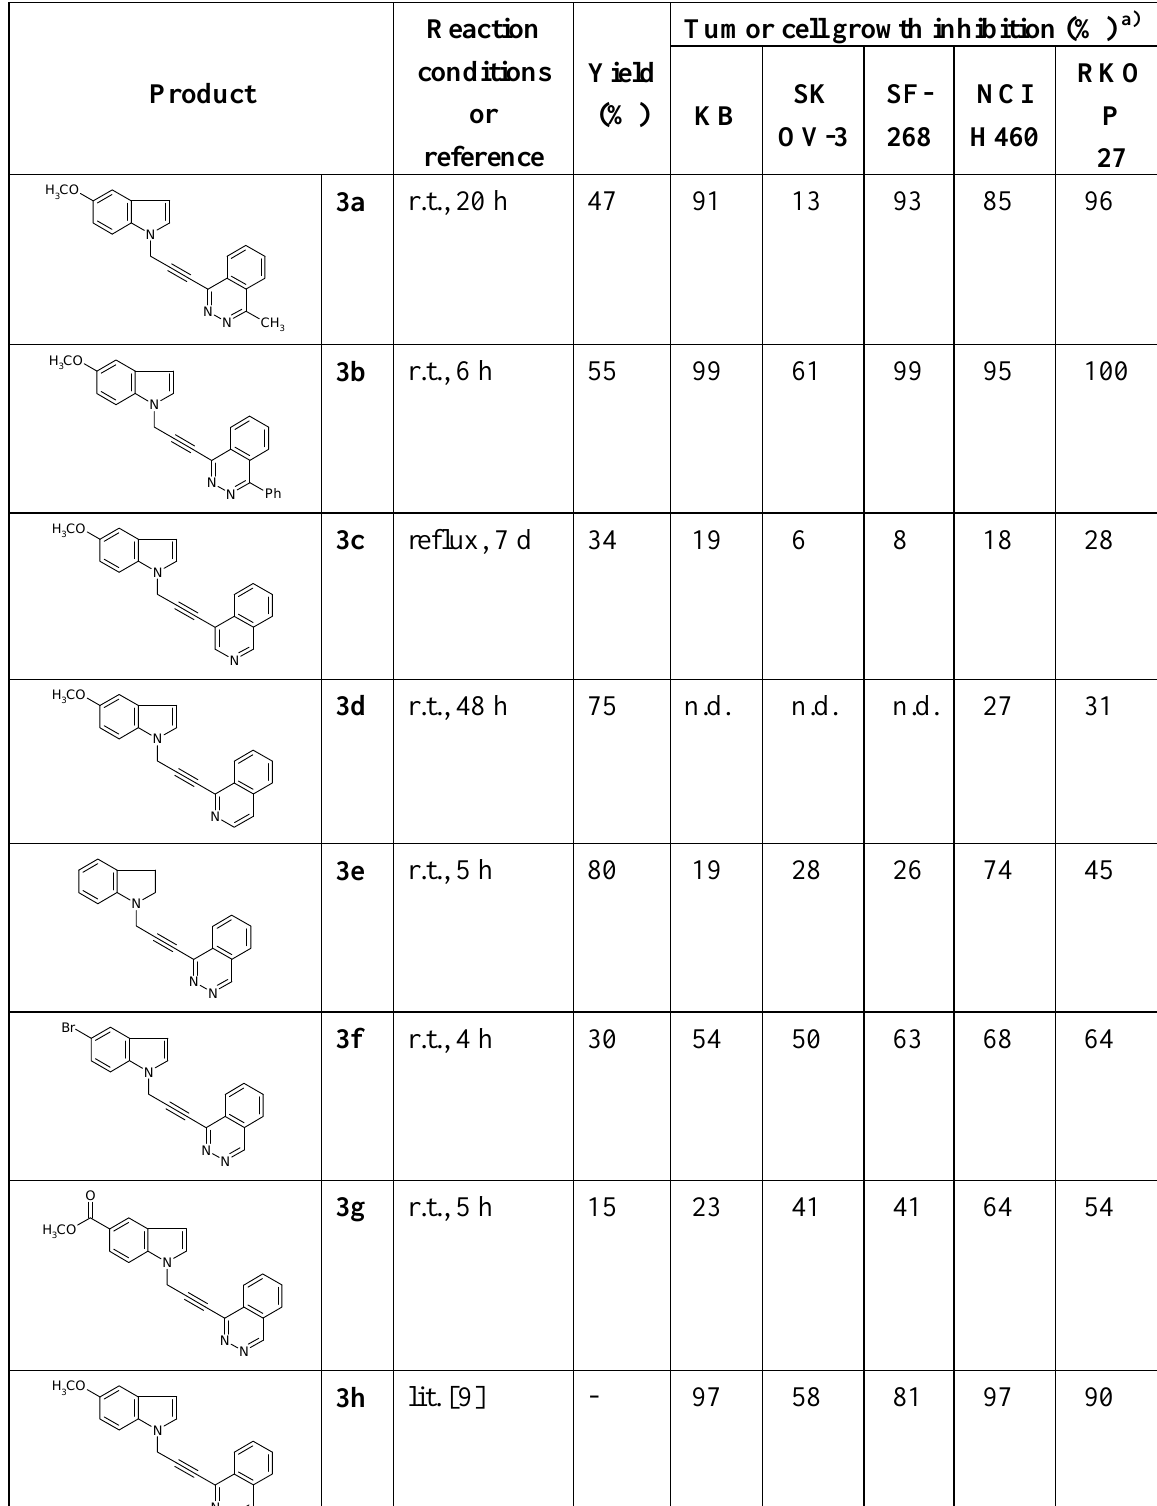
Table 1. Structures, reaction conditions, yields, and biological activities for the title